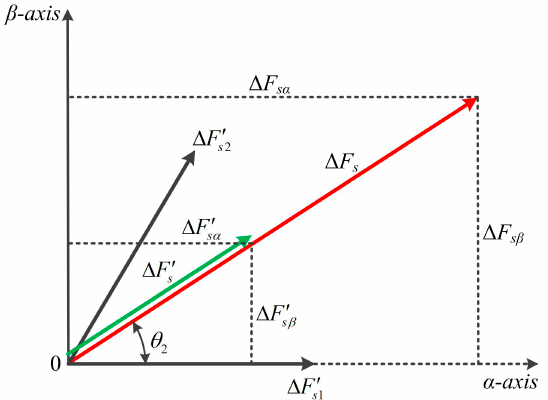
Figure 6. Analysis of error compensational effects in dynamic-state.